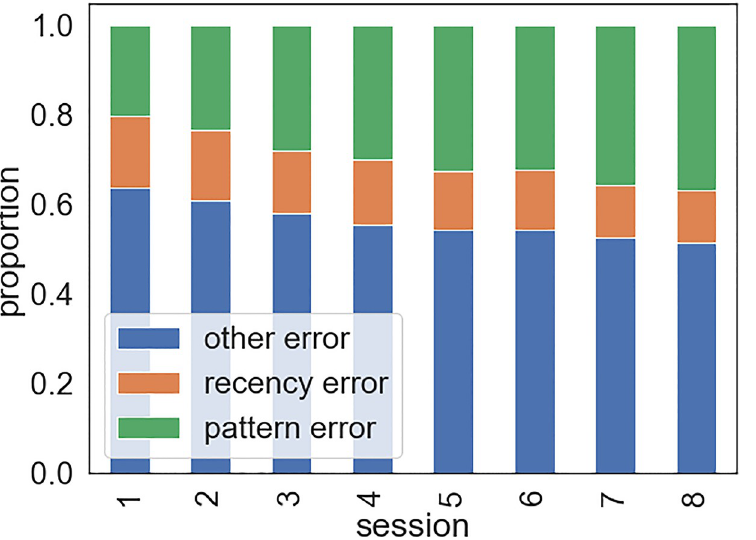
Fig 8. Proportions of errors of different types across training